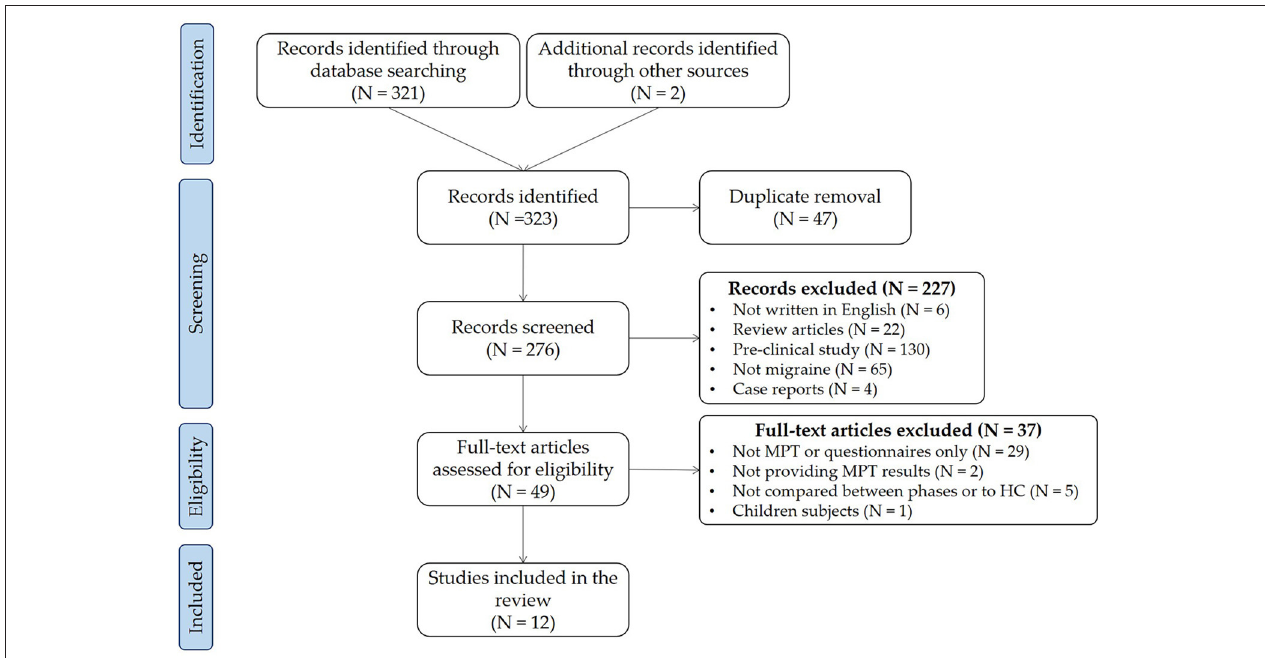
FIGURE 1 | The PRISMA flow